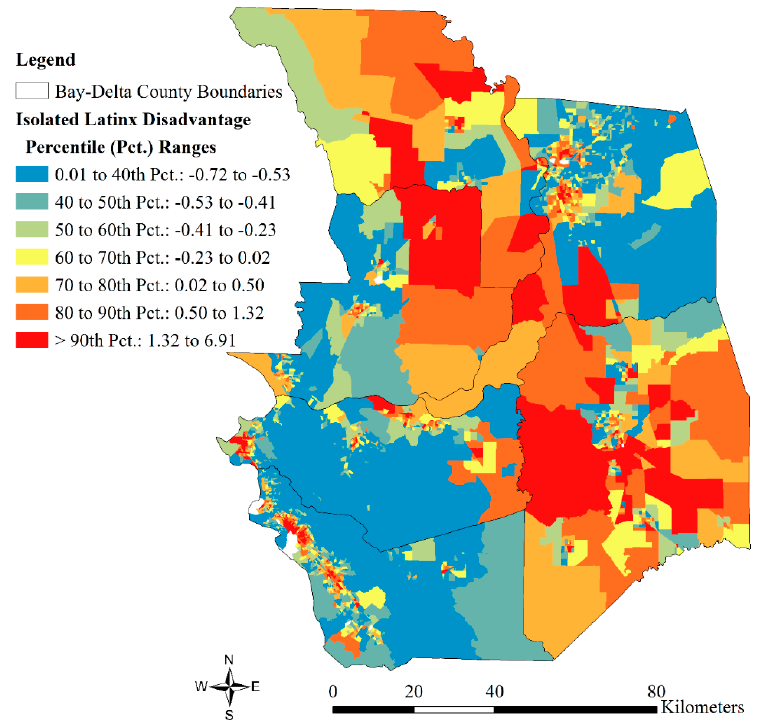
Figure 5. The spatial distribution of isolated Latinx disadvantage in the Bay-Delta, 2000 (N = 3061).